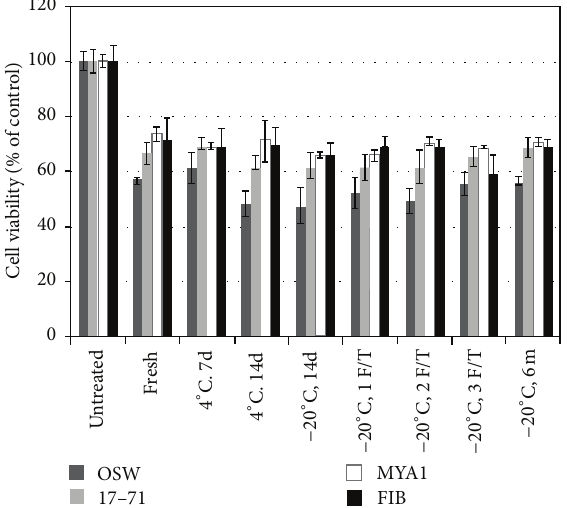
Figure 1: ASNase reduces cell proliferation in vitro . All cold-stored ASNase treatment groups decrease cell proliferation, 𝑃 < 0.05 . Cell lines demonstrate variable response to ASNase